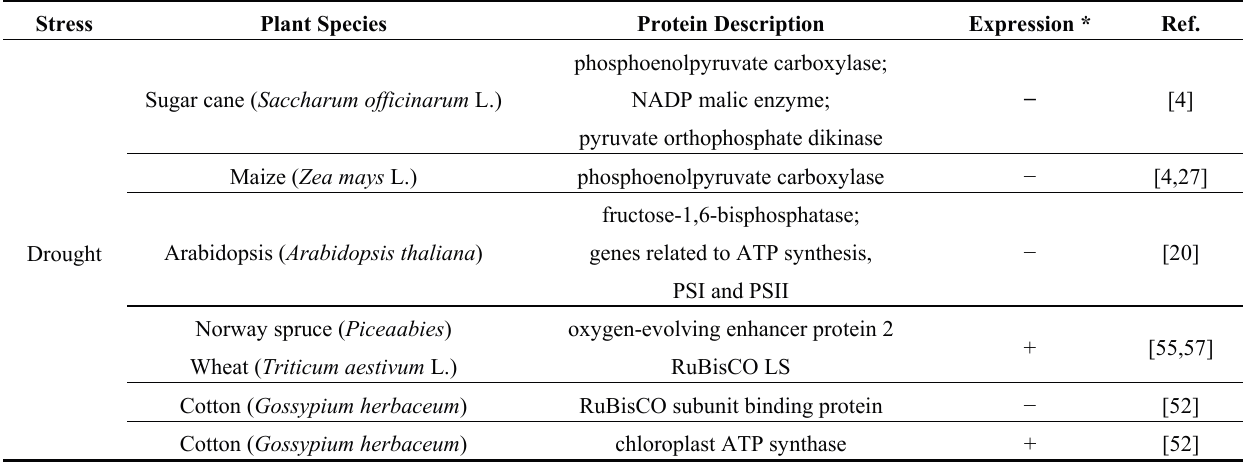
Table 2. Summary of selected differentially expressed proteins involved in photosynthesis pathway in response to abiotic